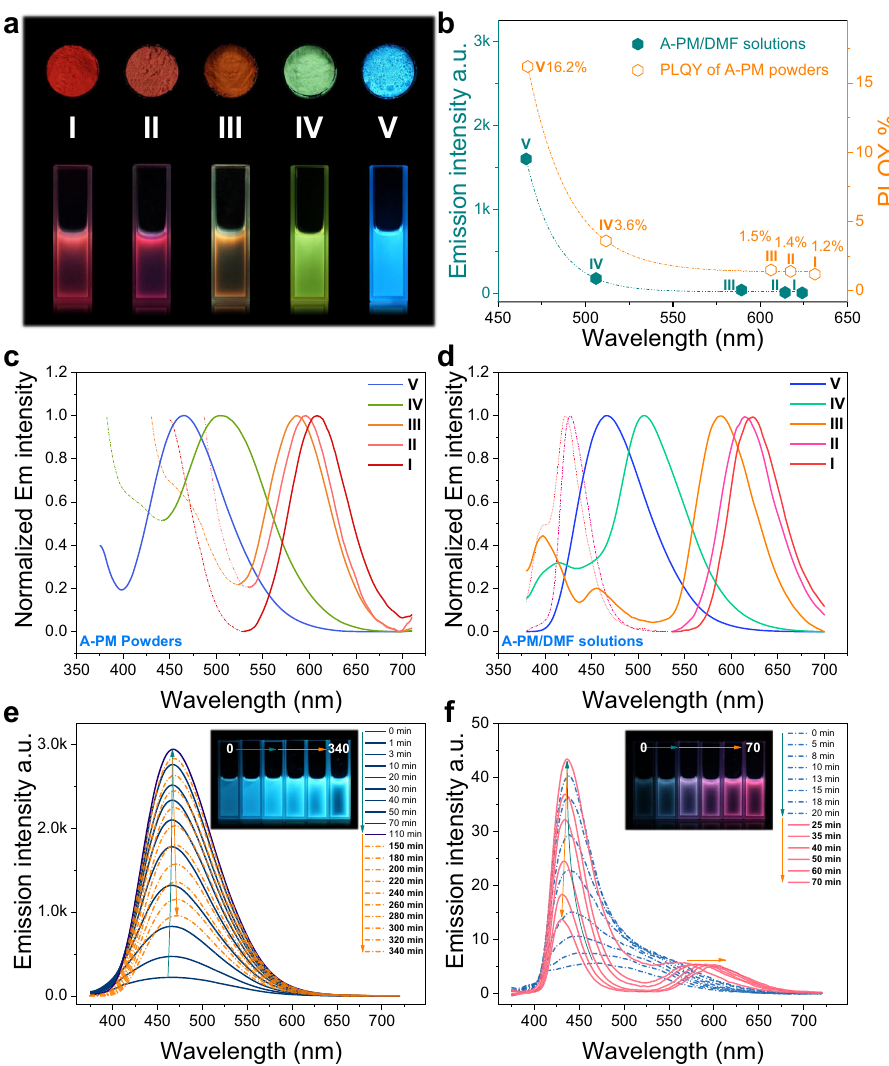
Fig. 2 Full-color emission of A-PM regulated by anionic polymerization. a Fluorescent images of A-PM powders and solutions in DMF synthesized with different Lewis bases (I, triethylamine, TEA; II, sodium bicarbonate, NaHCO 3 ; III, 1,8-diazabicyclo [5.4.0] undec-7-ene, DBU; IV, dimethylphenylphosphine, PMP; V, hexylamine, HA). b PLQY (%) of A-PM powders and emission intensity of A-PM/DMF solutions at λ max . c , d Normalized emission spectra of A-PMs powders and solutions. The concentrations of I, II, III, IV, and V in solutions were 3.5, 7.0, 1.1, 25.0, and 25.0 mg/mL, respectively. e , f Emission spectra variations of maleimide solutions initiated by HA and TEA respectively with the prolongation of reaction time at 80